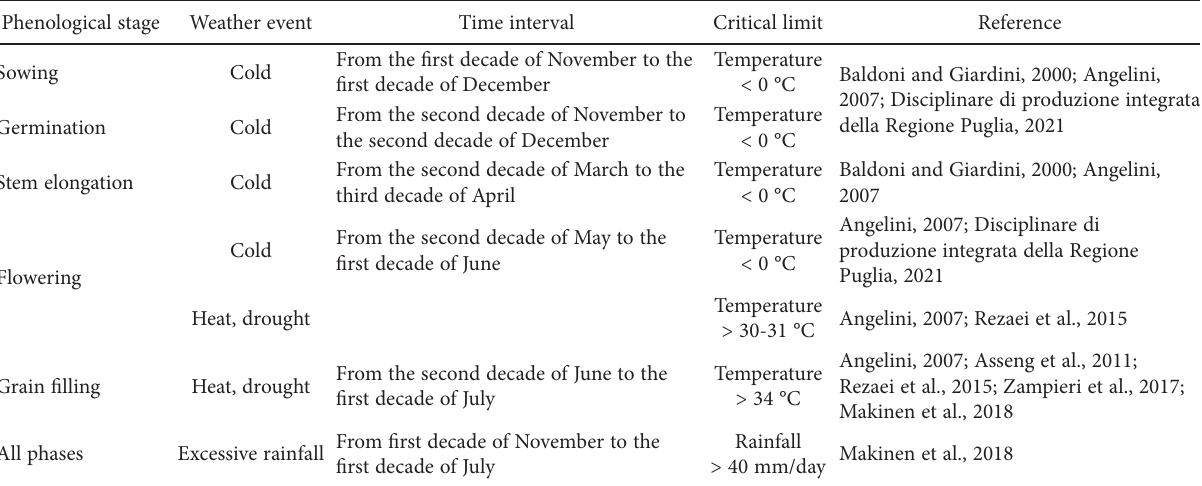
Table 1. Phenological stages, weather events and critical limits of durum wheat in Apulia region. Phenological